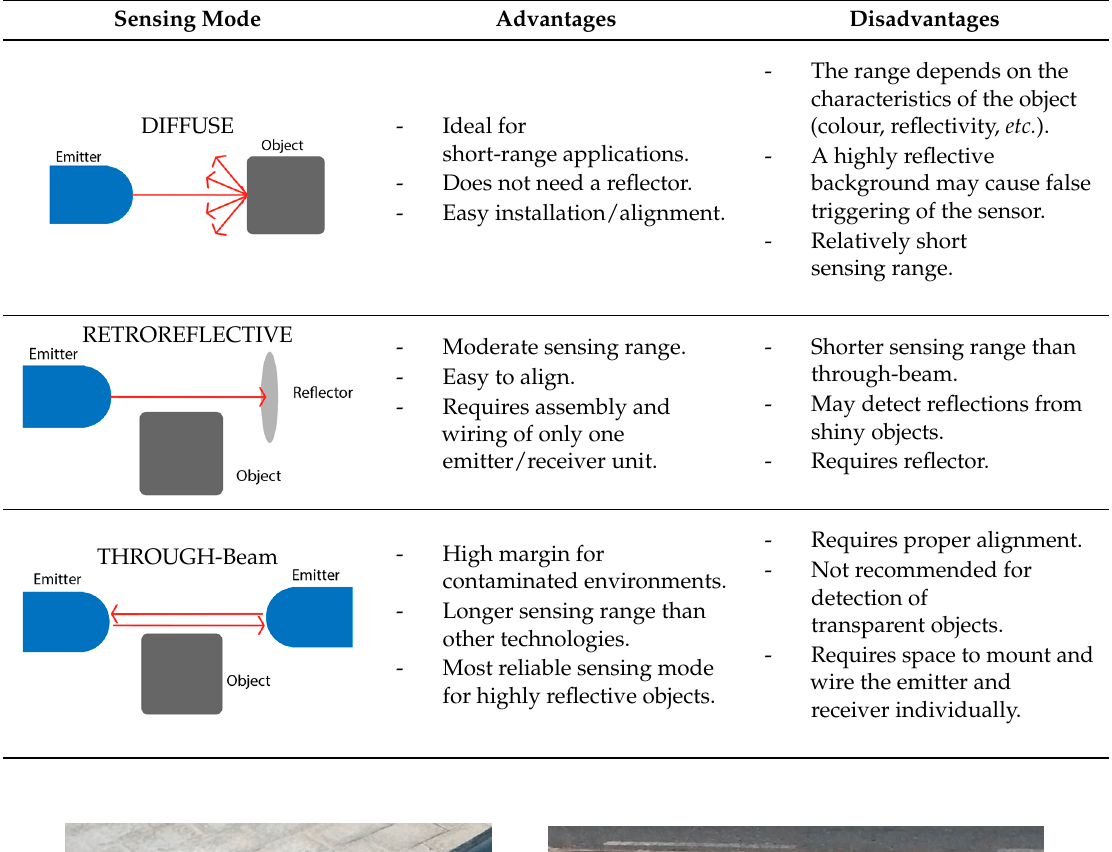
Table 1. Standard sensing modes of the sensor.